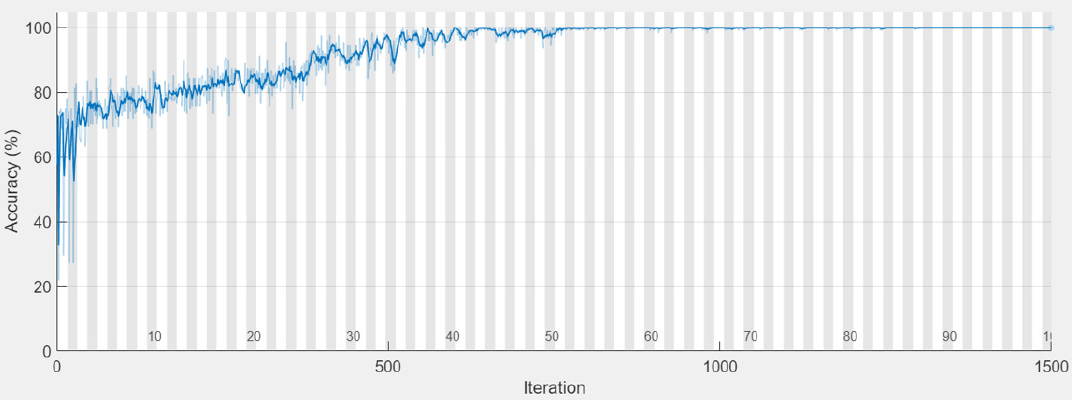
Figure 16. Accuracy according to the training progress (CNN-m2).